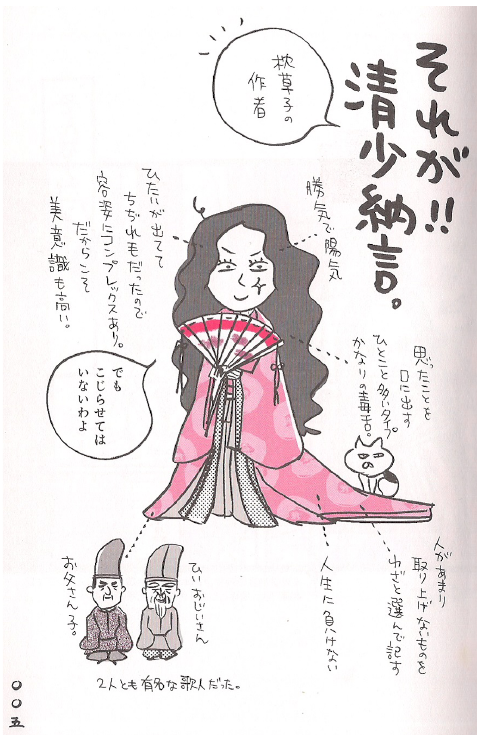
Figure 6. Sei appears as an outspoken, competitive, and confident woman.